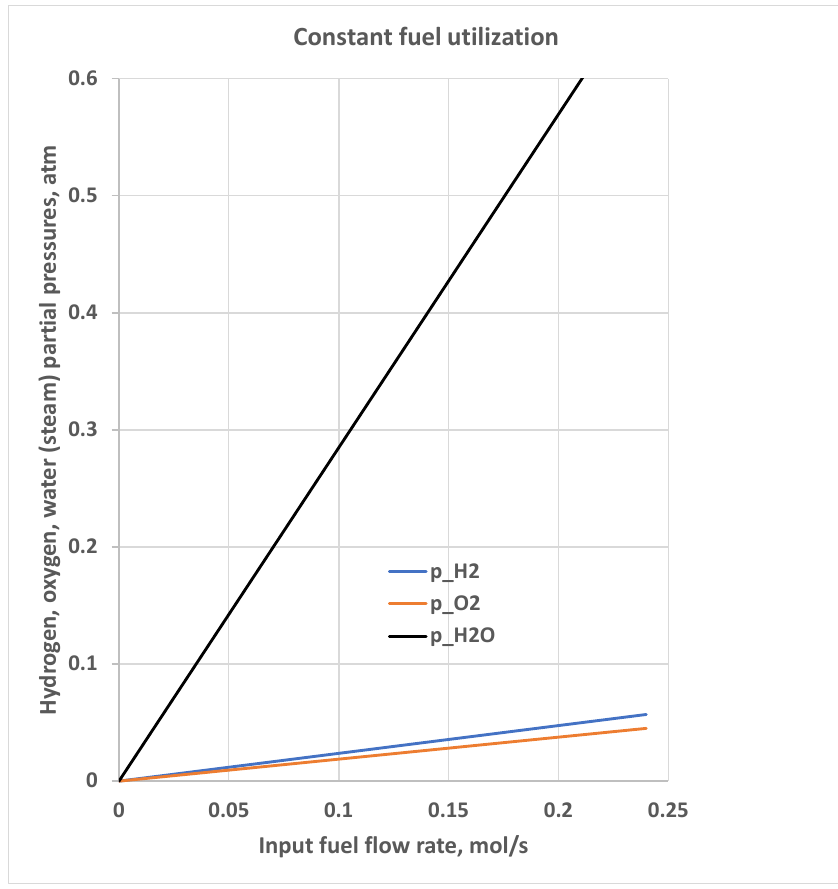
Figure 3. Linear dependence of the three partial pressures on the input fuel flow rate (under the constant fuel utilization